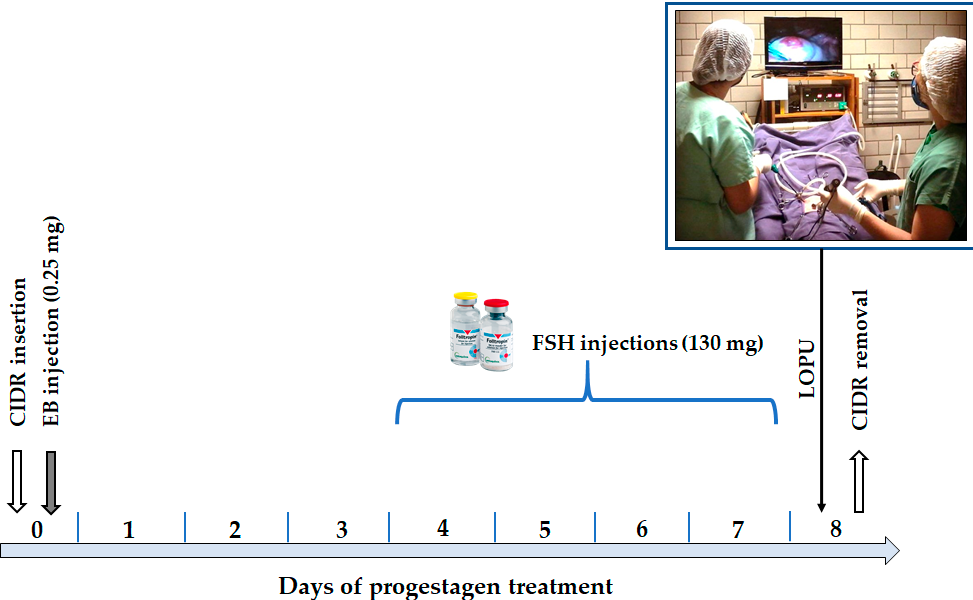
Figure 5. Schedule of the hormonal ovarian stimulation protocol used on females of M. gouazoubira and M. americana . CIDR: controlled internal drug release; EB: estradiol benzoate; FSH: follicle-stimulating hormone; LOPU: laparoscopic ovum pick-up.